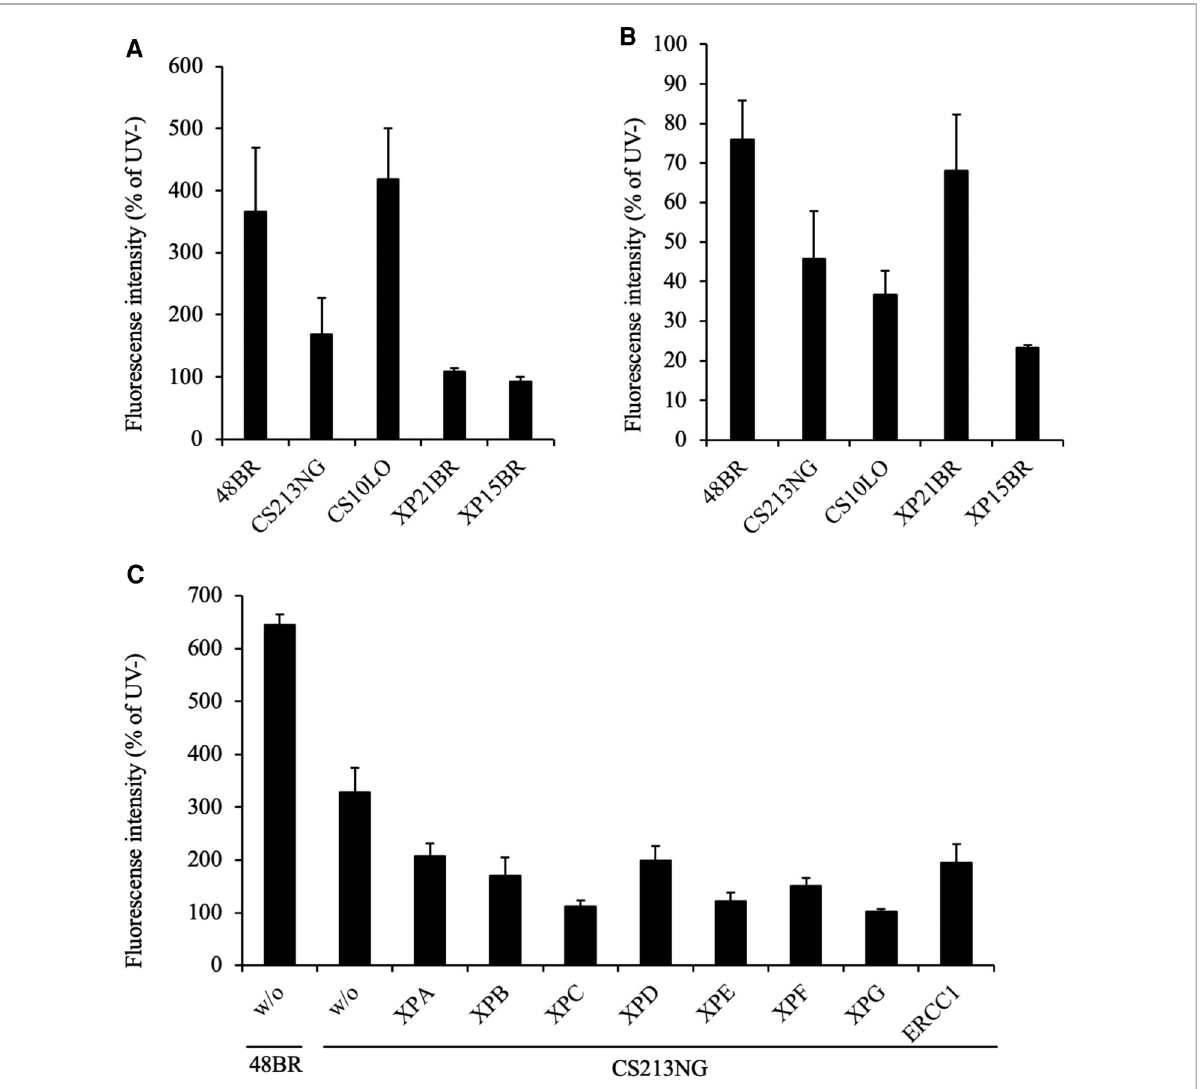
FIGURE 1 Examination of NER activity by UDS and RRS assays. ( A ) UDS activity after UV irradiation was impaired in CS213NG cells. 48BR (Normal), CS10LO (CS- B), XP21BR (XP-C), XP15BR (XP-A), and the patient-derived CS213NG cells were irradiated with 20 J/m 2 UVC followed by UDS measurements (* p < 0.05, two-tailed homoscedastic t -test, 48BR vs. CS213NG). ( B ) Normal but slightly reduced RRS activity in CS213NG cells (* p <0.05, 48BR vs. CS213NG; 13 J/m 2 UVC irradiation). UDS and RRS were normalised to activity in non-irradiated cells. Error bars represent the standard deviation (SD) of the mean nuclear fl uorescent intensity in triplicate samples ( A , B ). ( C ) UDS virus complementation assay (representative data). CS213NG cells were infected with lentiviruses expressing either of the XPA - XPG as well as ERCC1 cDNAs. Error bars represent the standard deviation of four